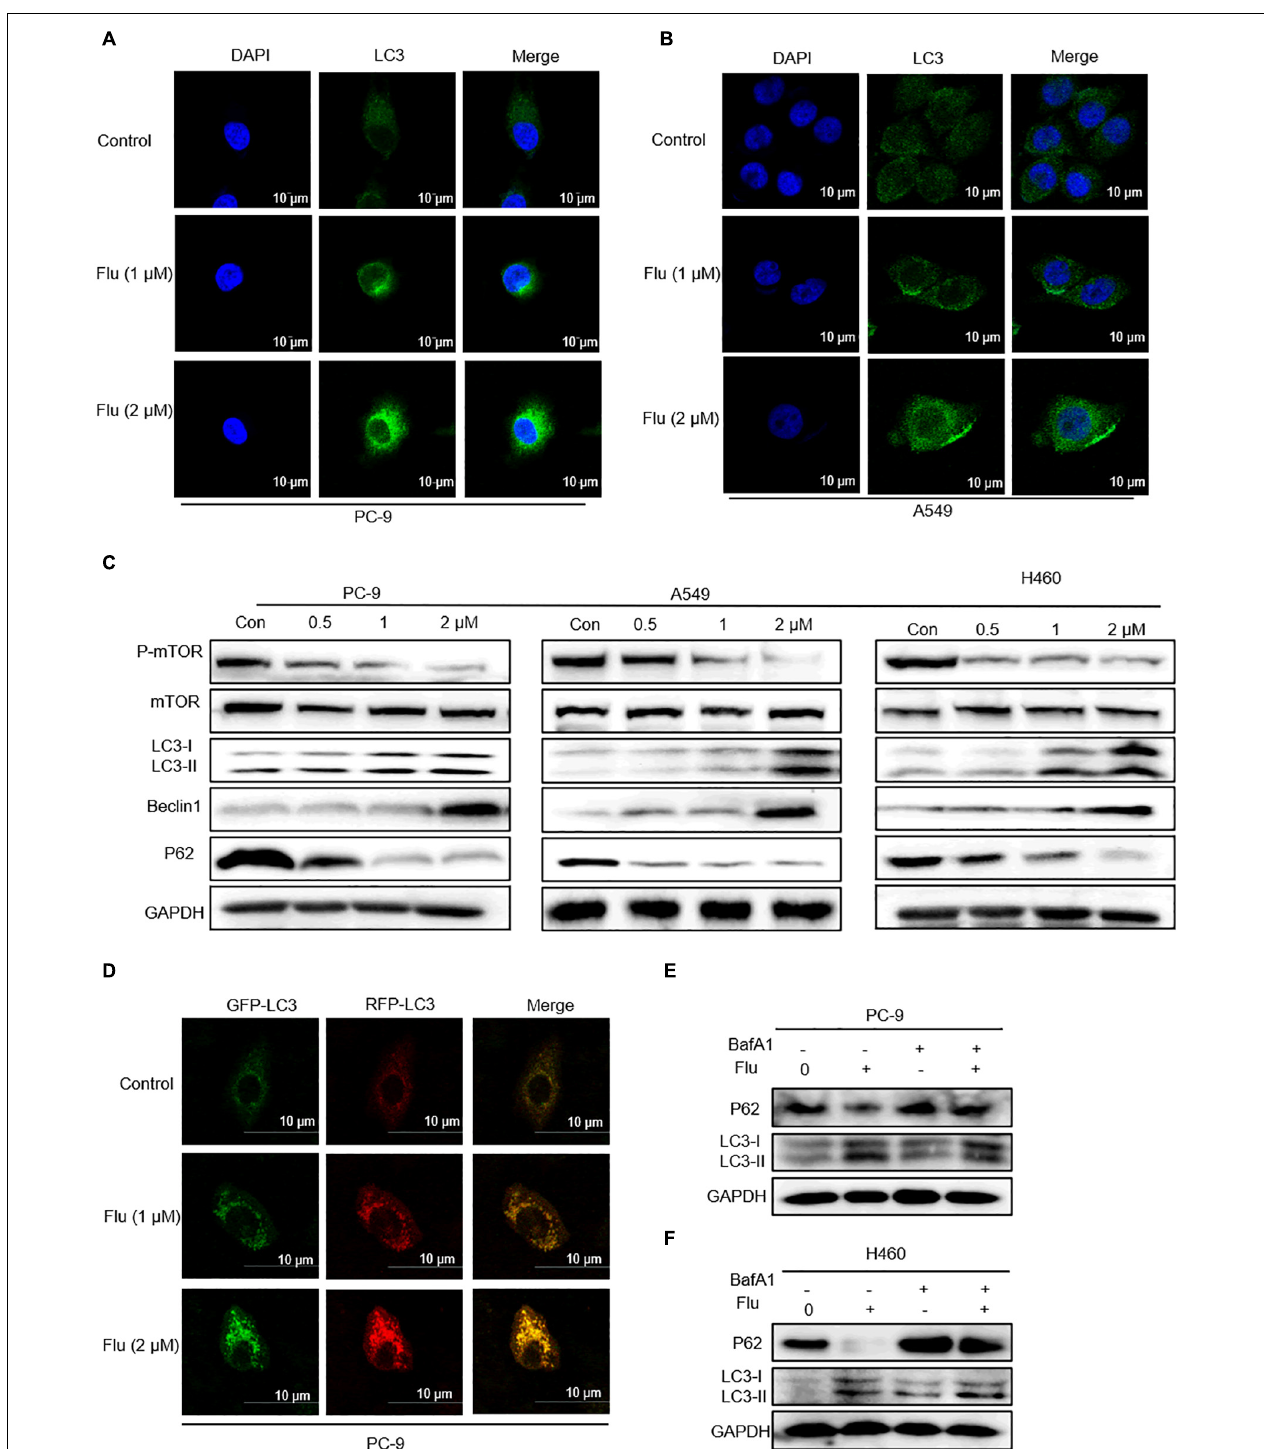
FIGURE 5 | Flubendazole induced autophagy in NSCLC cells. (A,B) Immunofluorescence study of endogenous LC3 in PC-9 and A549 cells treated with flubendazole (1 and 2 µ M) for 24 h. Representative figures with quantification of LC3 intensity. (C) Immunoblot analysis of p-mTOR, mTOR, p62, Beclin-1, and LC3 expression in three lung carcinoma cell lines treated with flubendazole (0.5, 1, and 2 µ M) for 24 h. GAPDH as a loading control. (D) Different localization patterns of the GFP and RFP signals of the tandem fluorescent LC3 (cid:48) s (RFP-GFP-LC3). Cells transfected with plasmids that express tandem fluorescent LC3. Cells treated with 1 and 2 µ M flubendazole at 24 h post-transfection and then analyzed by confocal microscopy. (E,F) PC-9 and A549 cells were co-incubated with flubendazole (1 µ M) in the presence or absence of BafA1 (20 nM) for 24 h, and then the expressions of p62 and LC3 were detected. Results shown are representative of three independent experimental processes. Images shown are representative of three separate experiments.